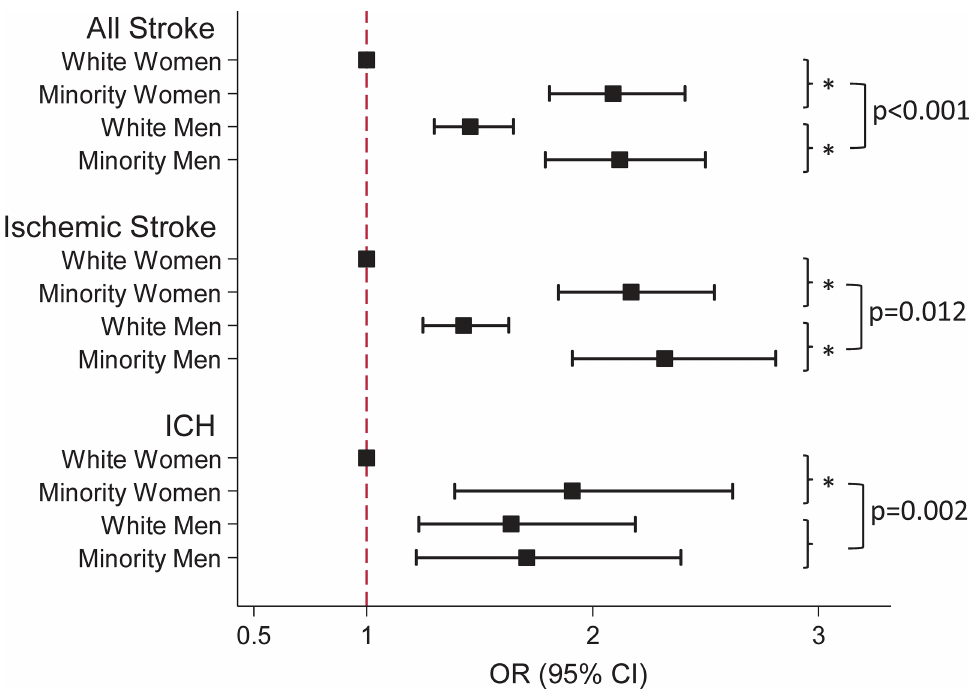
Fig 1. Graphic representation of odds ratios of PEG among ethnic/racial minority women, white men, and ethnic/ racial minority men, compared to white women as reference. Data are presented for all stroke (top panel), and stratified by stroke subtype (medium and lower panel), respectively. (cid:3) indicates a p-value < 0.001 for comparison of PEG in ethnic/ racial minority vs. white for each sex. P-values for interaction following square brackets compare the odds of PEG in ethnic/racial minorities vs. white between men and women. OR: odds ratio; CI: confidence interval; ICH: intracerebral hemorrhage.